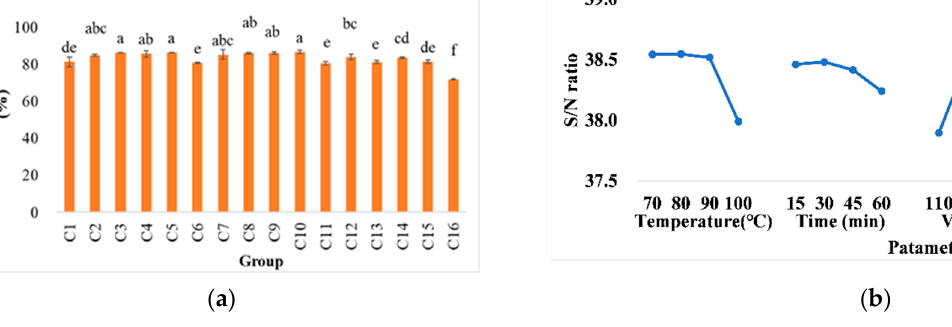
Figure 4. ( a ) The system performance efficiency, and ( b ) response graph of higher-better signal-to- noise ratios of various conditions in ohmic heating. Values C1–C16 represent pineapple cores in different treatment conditions including temperature (°C), time (min), voltage (V), and frequency (Hz), respectively: 1: 70, 15, 110, and 60; 2: 70, 30, 160, and 340; 3: 70, 45, 210, and 620; 4: 70, 60, 260,